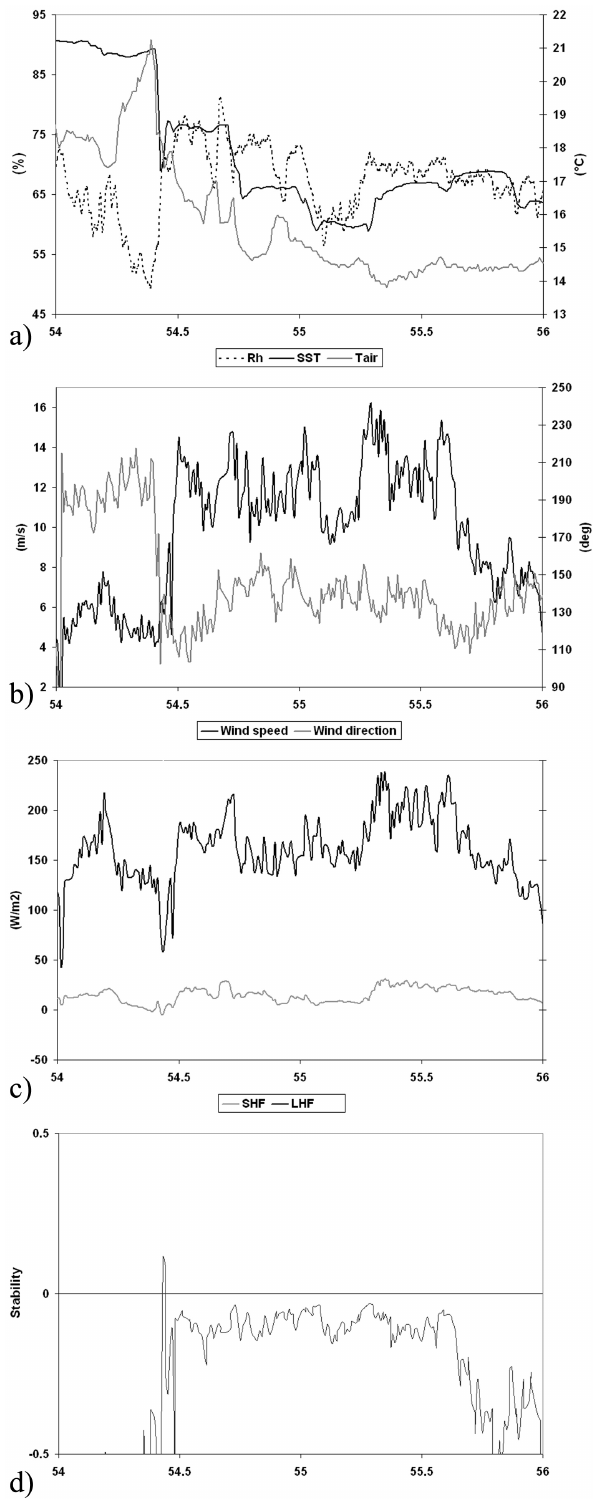
Fig. 8. Same as Fig. 6 but for days 54 to